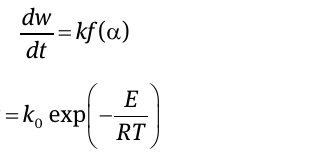
Fig. 1: XRD patterns of synthesized LaMn x Fe 1 − x O 3